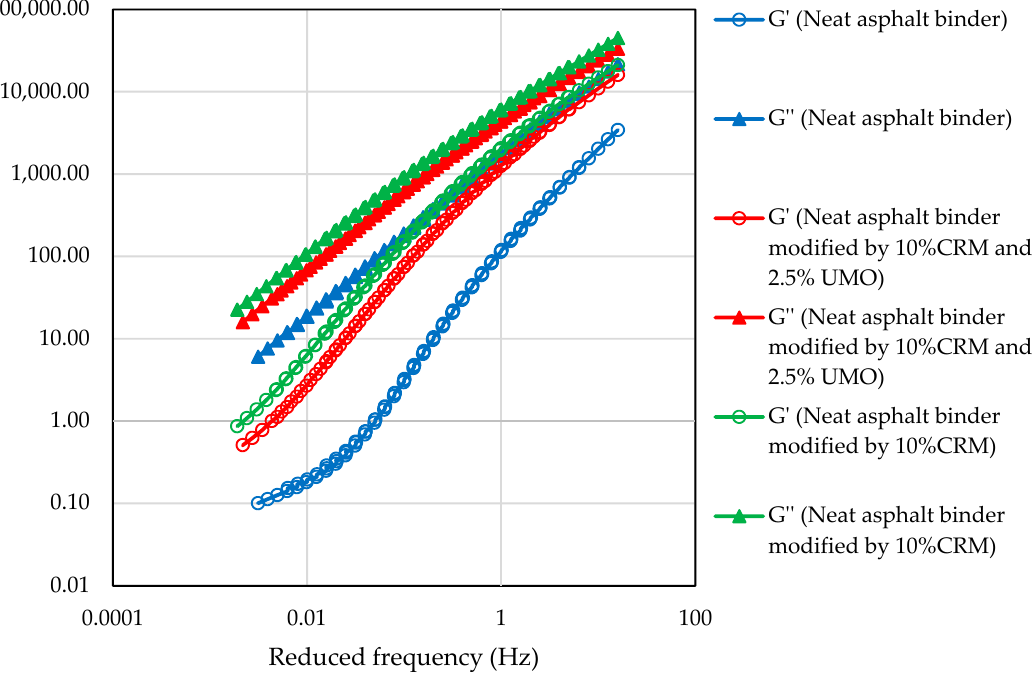
Figure 8. Master curve for PG 64-22 neat and modified asphalt binders interacted at 190 ◦ C—50 Hz—62 min, measured at 60 ◦ C as a reference temperature.